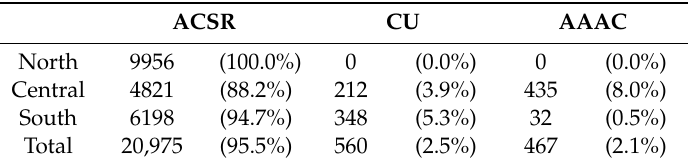
Table 1. Italian extra-high voltage level (EHV) and high voltage level (HV) transmission network extension divided by main wire types in (km) and in (%) respect to the